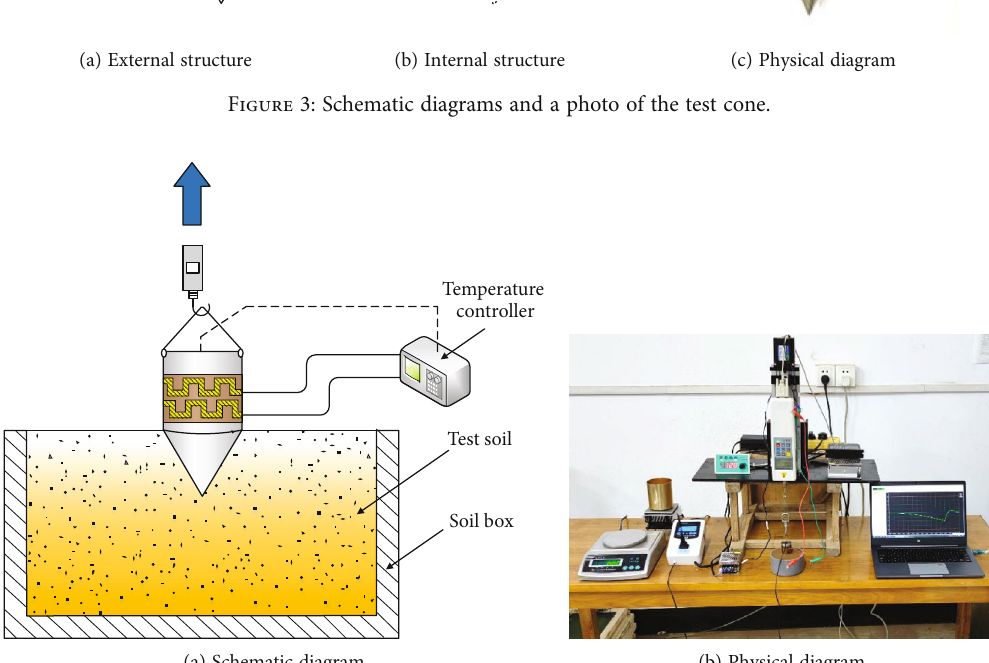
Figure 4: Experiment set-up of the adhesive